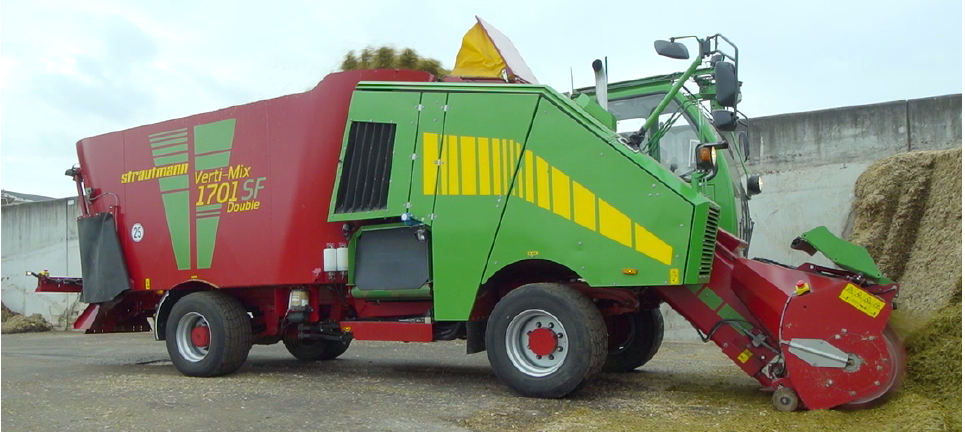
Figure 1. An unmanned feeding mixer is already working with autonomous driving and working functionality. In the developed safety concept, a non-contact sensor system is still missing for the human protection at the autonomous feeding mixer, which may be used both for indoor and outdoor on an agricultural